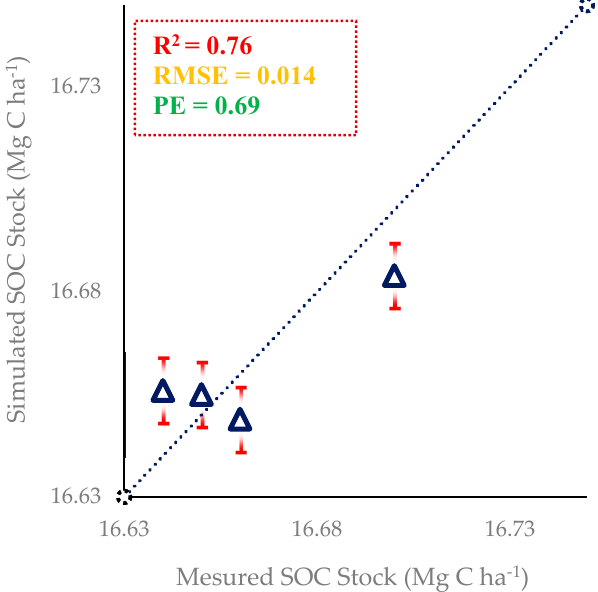
Figure 3. Measured and simulated SOC Stock in BandBast rangelands compared with 1:1 line.